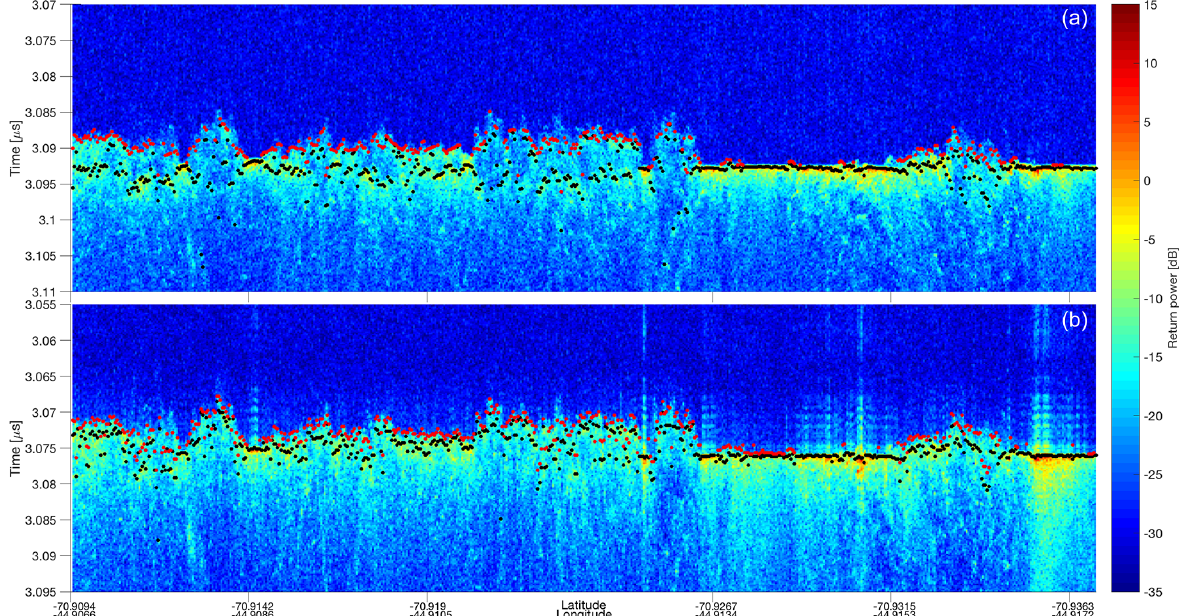
Figure 3. Example echograms from Operation IceBridge snow radar (a) and Ku-band radar (b) taken from the November 2012 Sea Ice Endurance campaign. Black points denote locations of maximum power and red points denote the first location where the power rises 10dB above the noise level, both found from the peak-picking algorithm discussed in the text. The length of the transect covered in this echogram is 3.02km. The mean (standard deviation) noise level for the snow radar is found to be − 29 . 1dB (1.39dB) while the signal level at the air–snow interface is found to be − 16 . 8dB (1.47dB). For the Ku-band altimeter, the noise level is found to be − 30 . 3dB (1.32dB) while the